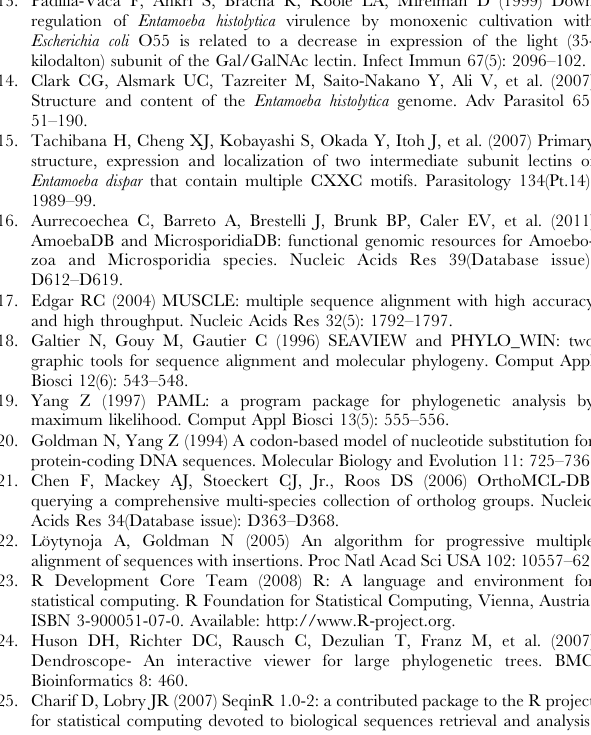
lectin orthologues EHI_065330 and EDI_244250. (PDF) Figure S6 Nucleotide alignment of orthologous genome regions of E. histolytica and E. dispar used to estimate inter-specific divergence around the light chain lectin orthologues EHI_049690 and EDI_071530. (PDF) Figure S7 Nucleotide alignment of orthologous genome regions of E. histolytica and E. dispar used to estimate inter-specific divergence around the light chain lectin orthologues EHI_159870 and EDI_325130. (PDF) Figure S8 Amino acid multiple alignment of intermediate chain lectin ( igl ) gene family members from E. histolytica and E. dispar , used to generate a gene phylogeny. (PDF) Figure S9 Amino acid multiple alignment of light chain lectin ( lgl ) gene family members from E. histolytica and E. dispar , used to generate a gene phylogeny. (PDF) Figure S10 Nucleotide multiple alignments of intermedi- ate chain ( igl ) lectin gene family members from E. histolytica and E. dispar , used for sequence similarity plot.